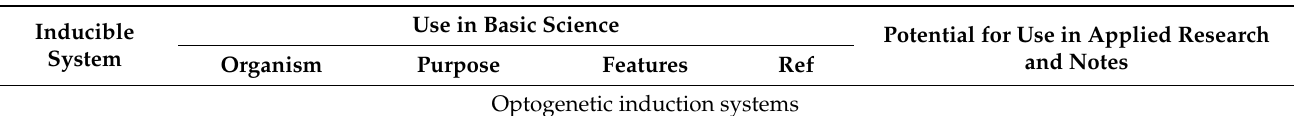
Table 1. Application of optogenetic and chemical induction systems in basic science and their potential use in applied